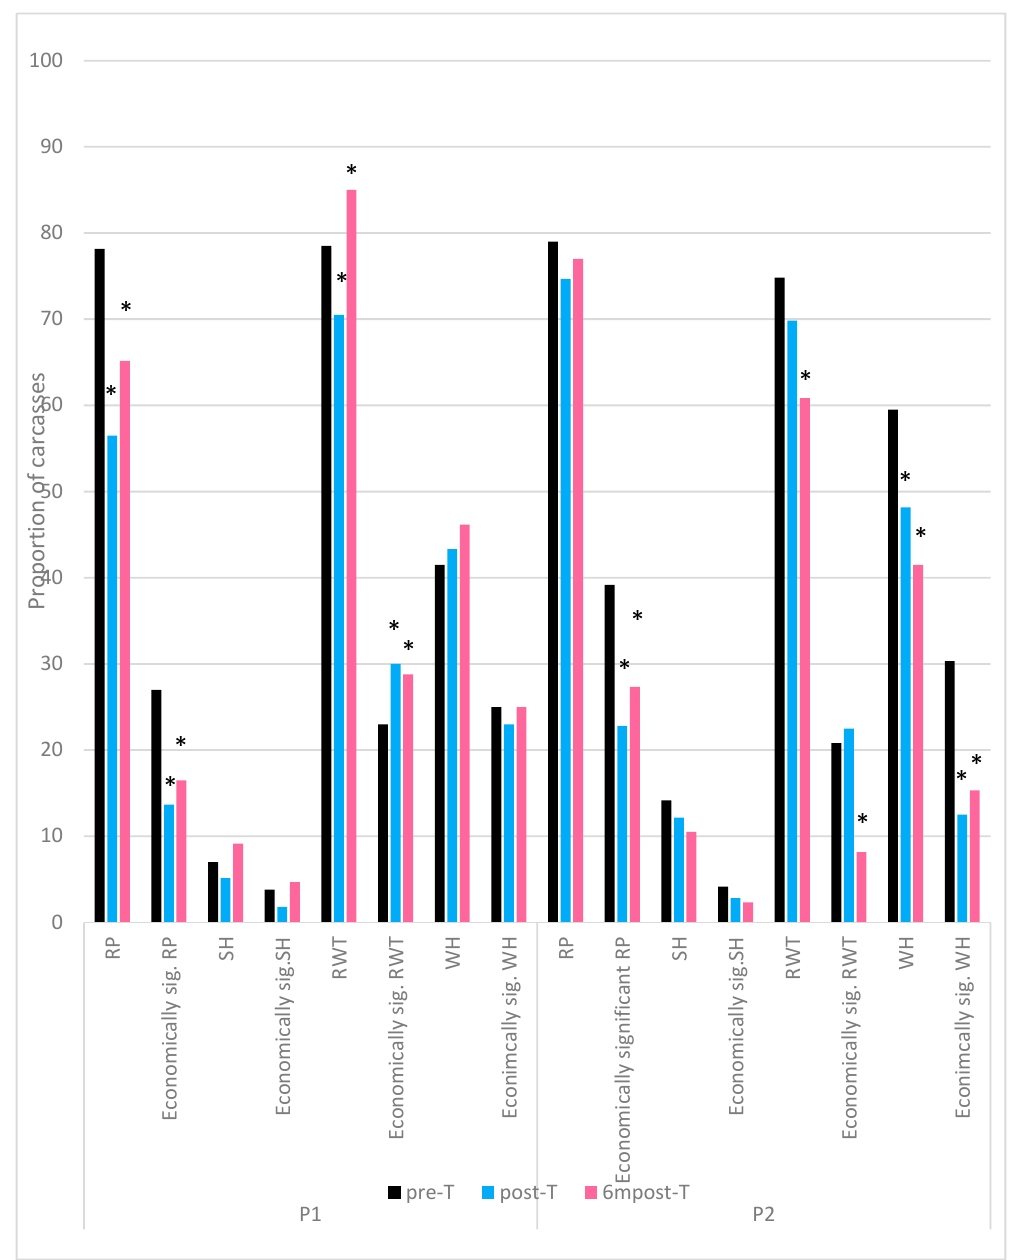
Figure 8. Proportion of carcasses with product quality defects (RP—red pygostyles; SH—shoulder haemorrhage; RWT—red wing tips; WH—wing haemorrhage) and economically significant quality defects (RP—quality assessment score 2; SH, RWT, WH—quality assessment score 2 and 3). * represents a statistically significant difference in proportion from pre-training visit ( p ≤ 0.05) calculated using the exact Chi-squared test.